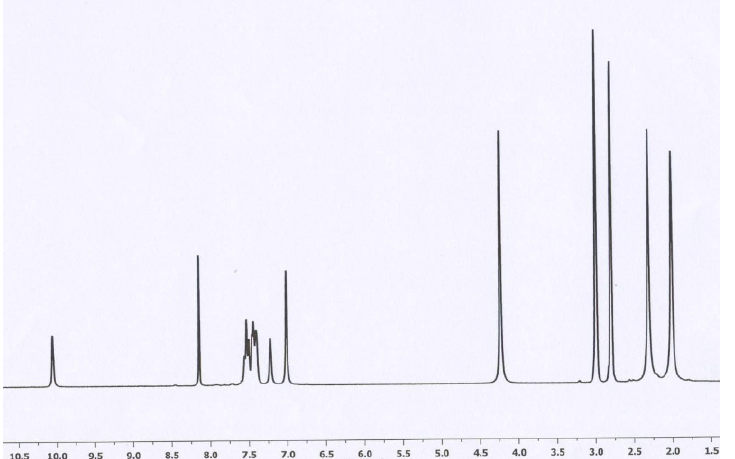
Figure 6. Hydroxygalvinoxyl and suggested three component system from [4]